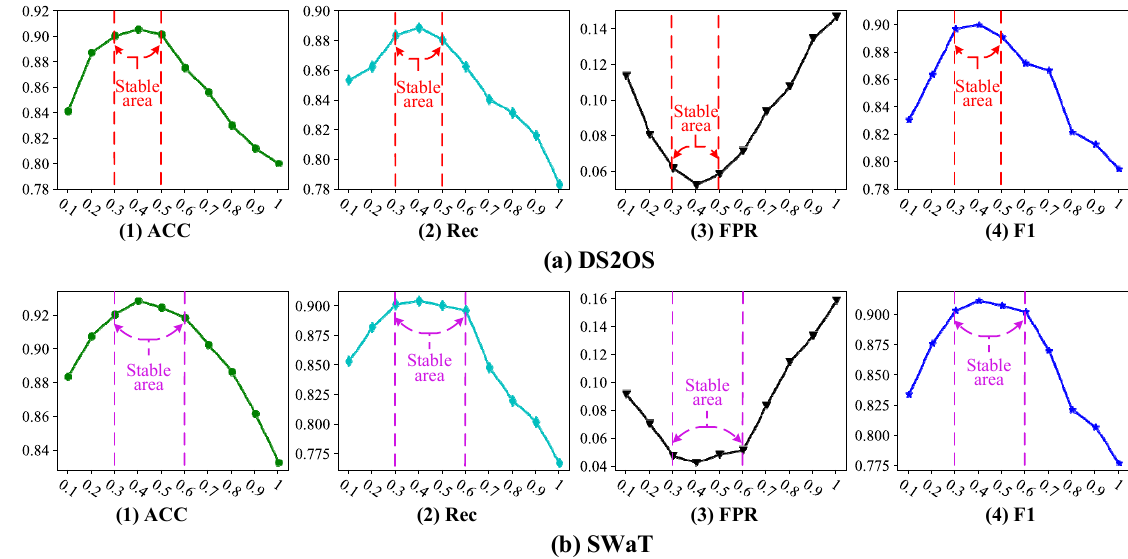
Figure 6. Sensitivity analysis of hyper-parameter γ .